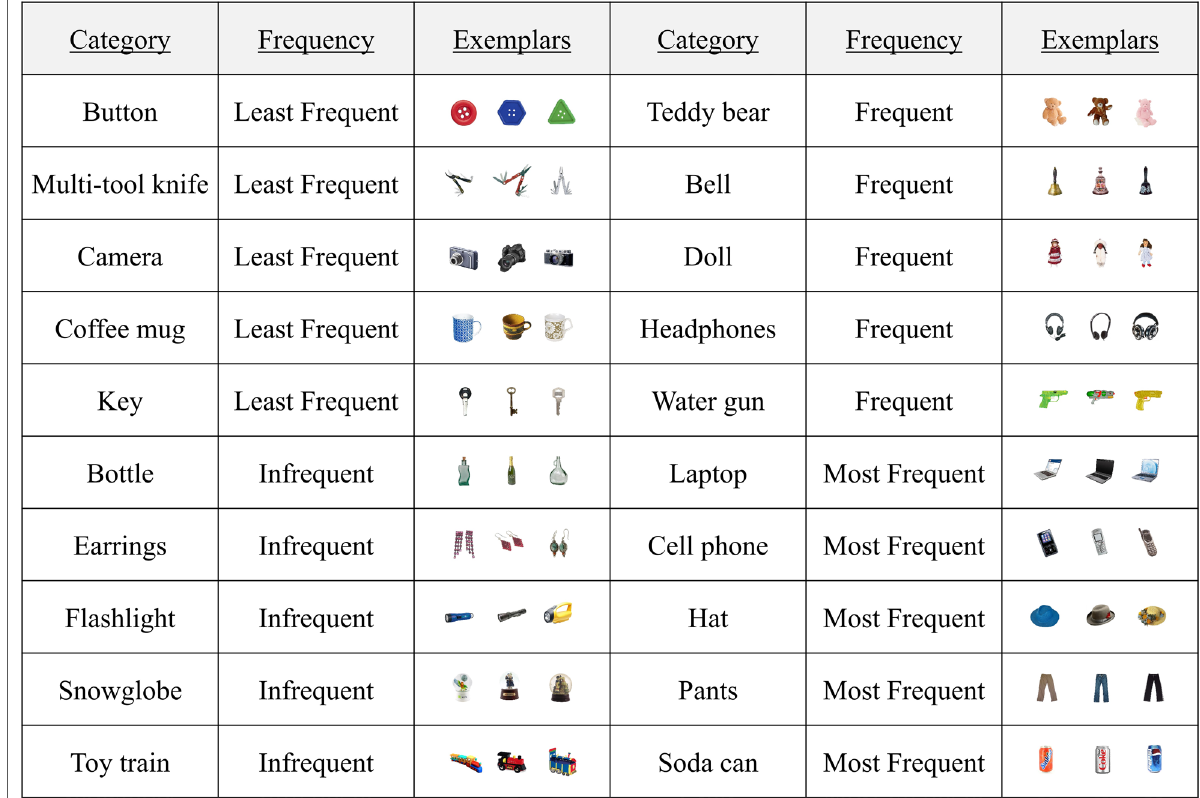
Fig. 1 Target categories searched for by all participants, with corresponding frequency level. For each, three randomly chosen exemplars are displayed for demonstrative purposes, but each category was comprised of 16 possible exemplars in the